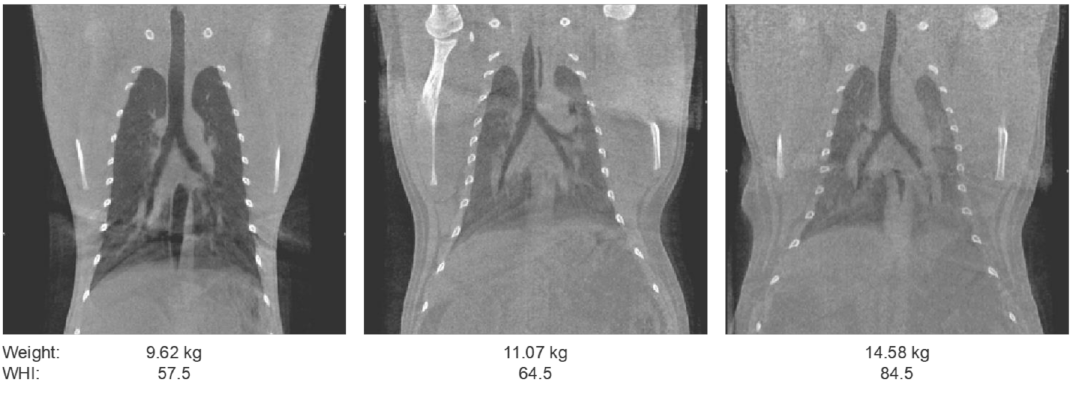
Figure 2. From left to right, three representative coronal sections of a thorax computed tomography (CT) are presented with their respective weight and weight-for-height index (WHI). With an increasing weight the contrast between the lungs and surrounding tissue is decreasing. While the amount of noise over the entire image is increasing. Similar window-level settings are applied to all